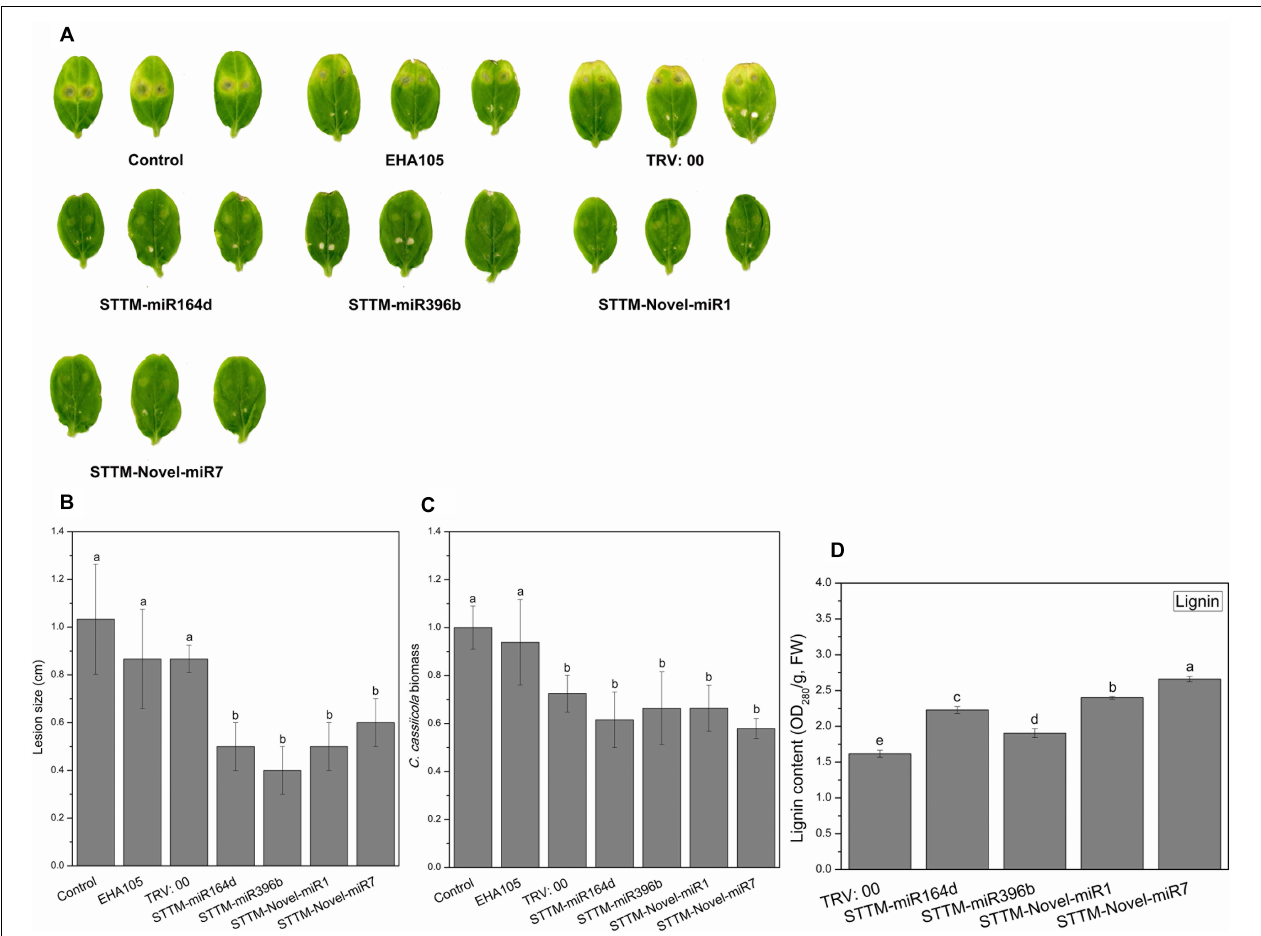
FIGURE 7 | Disease phenotype in STTM transgenic cucumber cotyledons after inoculation with C. cassiicola . (A) Disease symptoms of cucumber cotyledons. (B) Disease lesion size of cucumber cotyledons. (C) Biomass of C. cassiicola of cucumber cotyledons. (D) Effect of candidate miRNAs silencing on lignin content in cucumber cotyledons. Significance was determined by Duncan’s multiple range test ( P <